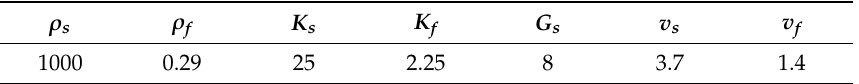
Table 1. Values used for the material parameters in Equations (6)–(11) (see text for units). ρ ρ s f K s K f G s v s v f 1000 0.29 25 2.25 8 3.7